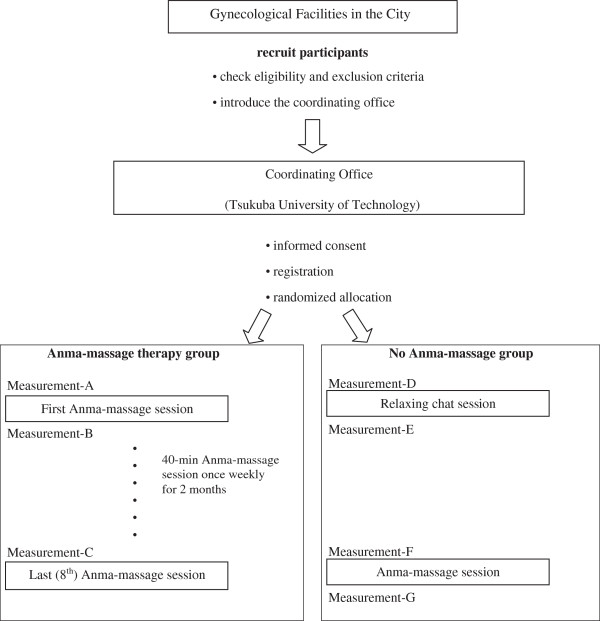
Trial Flow Diagram.